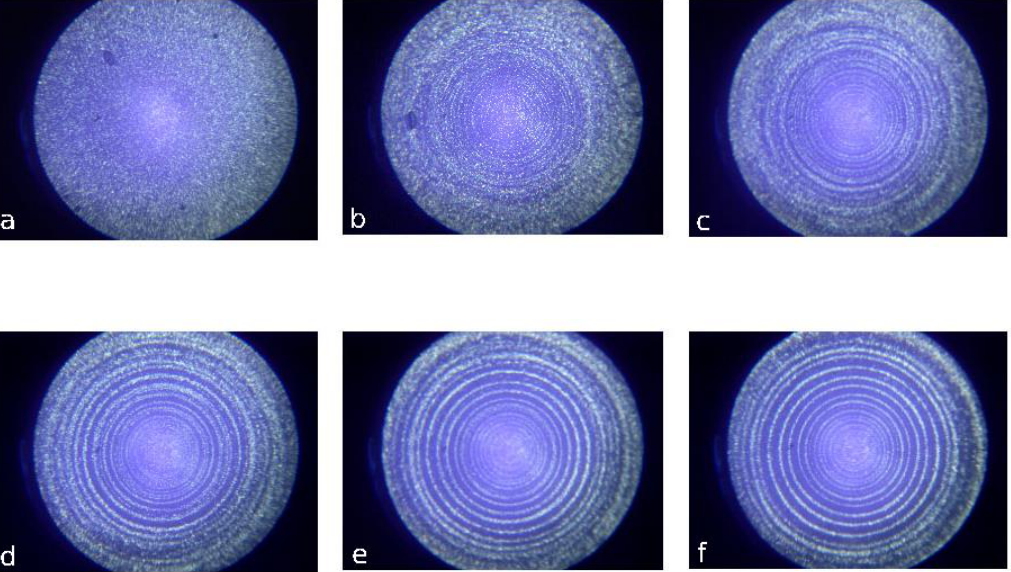
Figure 16. Consequent shots illustrating the kinetics of self-organization in rotational shearing of polyisobutylene solution filled with solid clay particles. Letters from ( a – f ) correspond to an increase in the time of shearing from 2 to 12